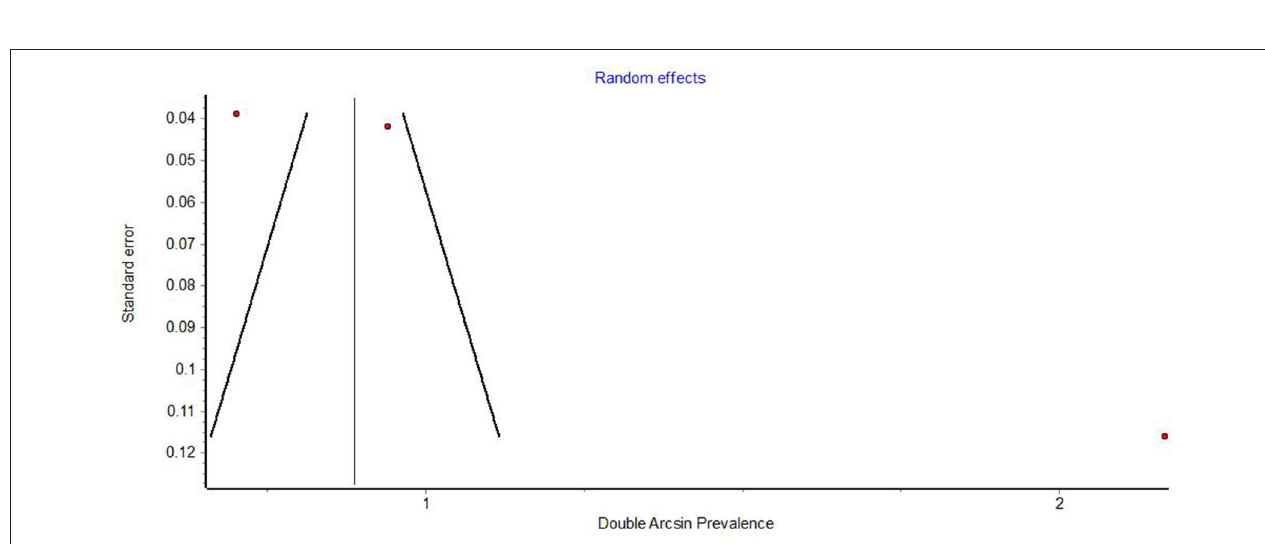
FIGURE 6 | Funnel plot of studies on the prevalence of oral lesions in general.